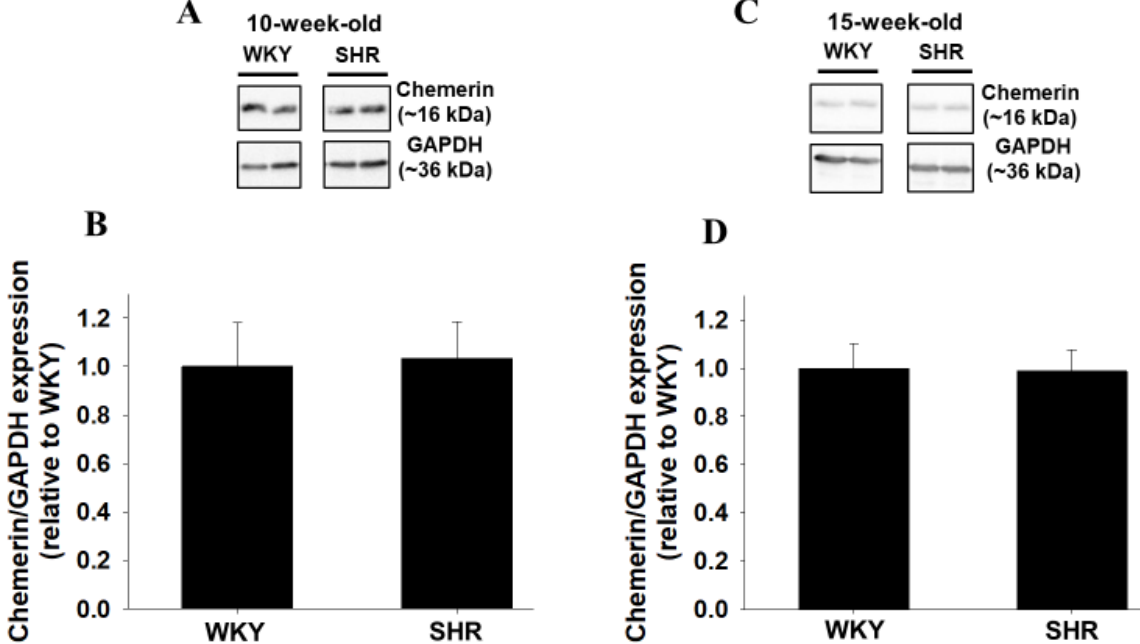
Figure 5. Protein expression of chemerin around brain ventricles of WKY and SHR. Protein expression of chemerin around brain ventricles of male WKY and SHR (( A , B ):10-week-old, ( C , D ): 15-week-old) was determined by Western blotting. Representative blots were shown ( A , C ). The normalized chemerin expression relative to GAPDH expression was shown as relative to WKY. Data were shown as mean + SEM in bar graph (( B ): n = 4, ( D ): WKY; n = 5, SHR; n = 4).